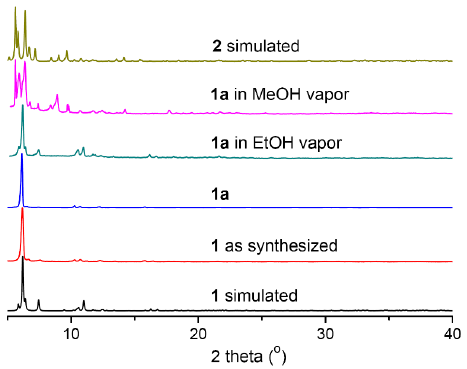
Figure 2. PXRD patterns of compound 1 , 1a in air, 1a in EtOH and MeOH vapors, and the simulated patterns of 1 and 2 from the SCXRD data.